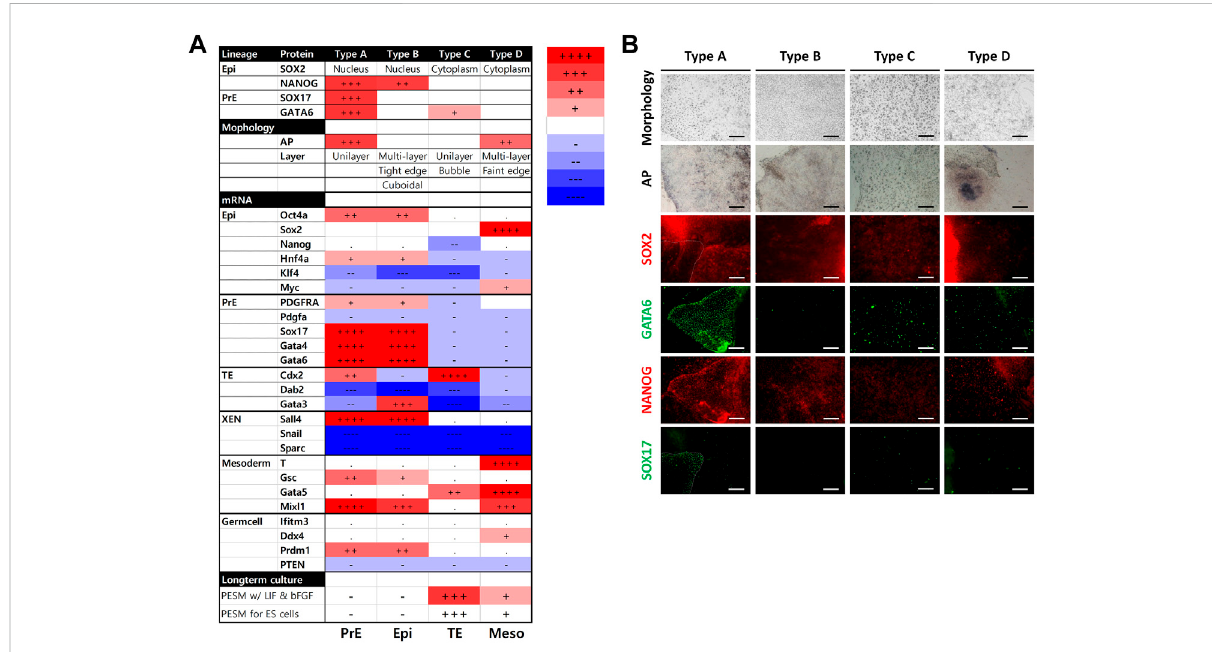
FIGURE 3 Summary of the results from the four types of cells. (A) Summary of characteristics for the cell types. mRNA levels were determined using porcine embryonic fi broblasts as a control. The number of + or − represents the level of statistical signi fi cance. (+ or − , p < 0.05; ++ or − , p < 0.01; +++ or − , p < 0.001; ++++ or − , p < 0.0001) (B) Summary of bright- fi eld and immunocytochemistry images. Images were collected from Figure